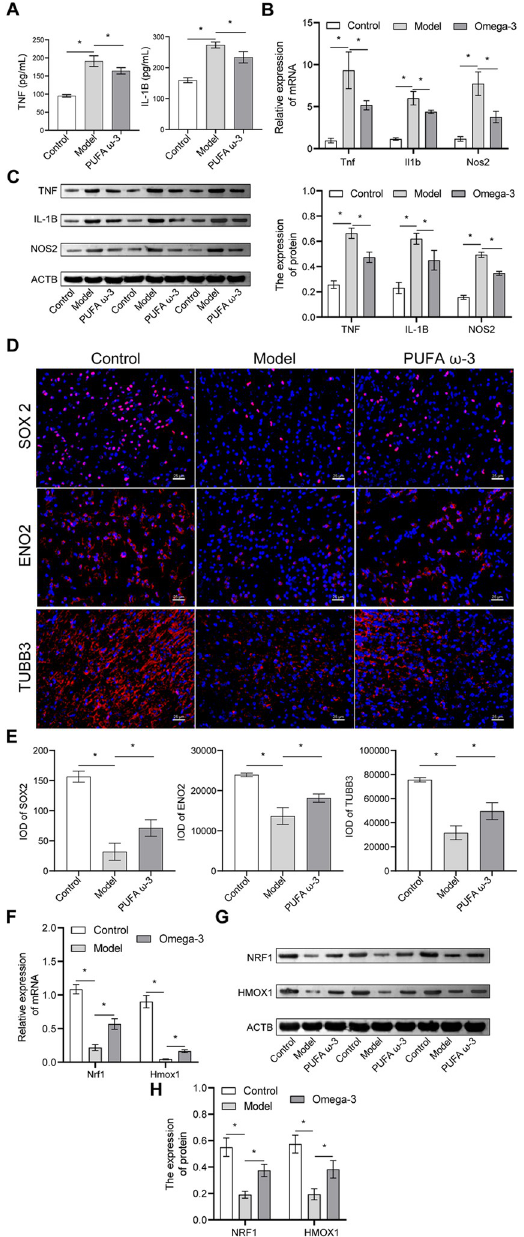
Fig 4. PUFA ω -3 alleviates sodium nitrite exposure-induced cerebral cortical tissue damage in fetal rats via the NRF1/HMOX1 pathway. (A) TNF and IL-1B concentrations were detected by ELISA, n = 3 rats/group. (B-C) The mRNA and protein expression levels of Tnf , Nos2 , and Il1b were detected by qRT-PCR and western blot, n = 3 rats/ group. Original blots are presented in S2A Fig. (D) Expression levels of SOX2, ENO2, and TUBB3 in the brain cortical tissue of each group were detected by IF, n = 3 rats/group. (E) IOD data statistics of SOX2, ENO2, and TUBB3 expression in the brain cortical tissue of each group were analyzed by Image-Pro-Plus, n = 3 rats/group. (F-H) Nrf1 and Hmox1 mRNA and protein expression levels were analyzed by qRT-PCR and western blot, n = 3 rats/group. Original blots are presented in S2B Fig. � P < 0.05. IF, immunofluorescence; IL-1B, interleukin-1 beta; IOD, integrated optical density; qRT-PCR, quantitative real-time PCR; TNF, tumor necrosis factor.